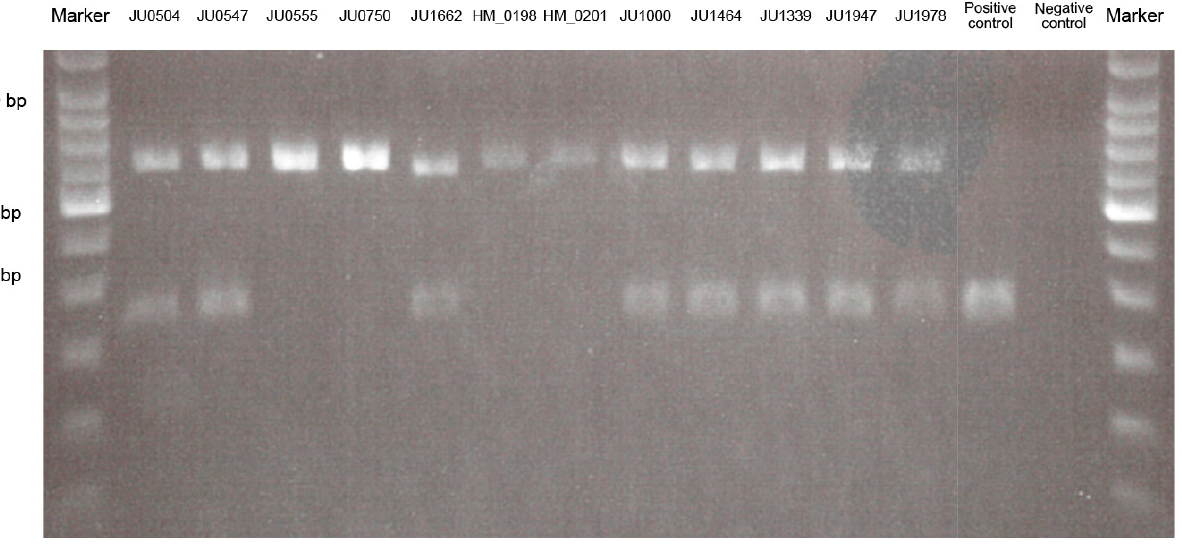
Figure 2. Results of the polymerase chain reaction-length polymorphism analysis for Alu element insertion.